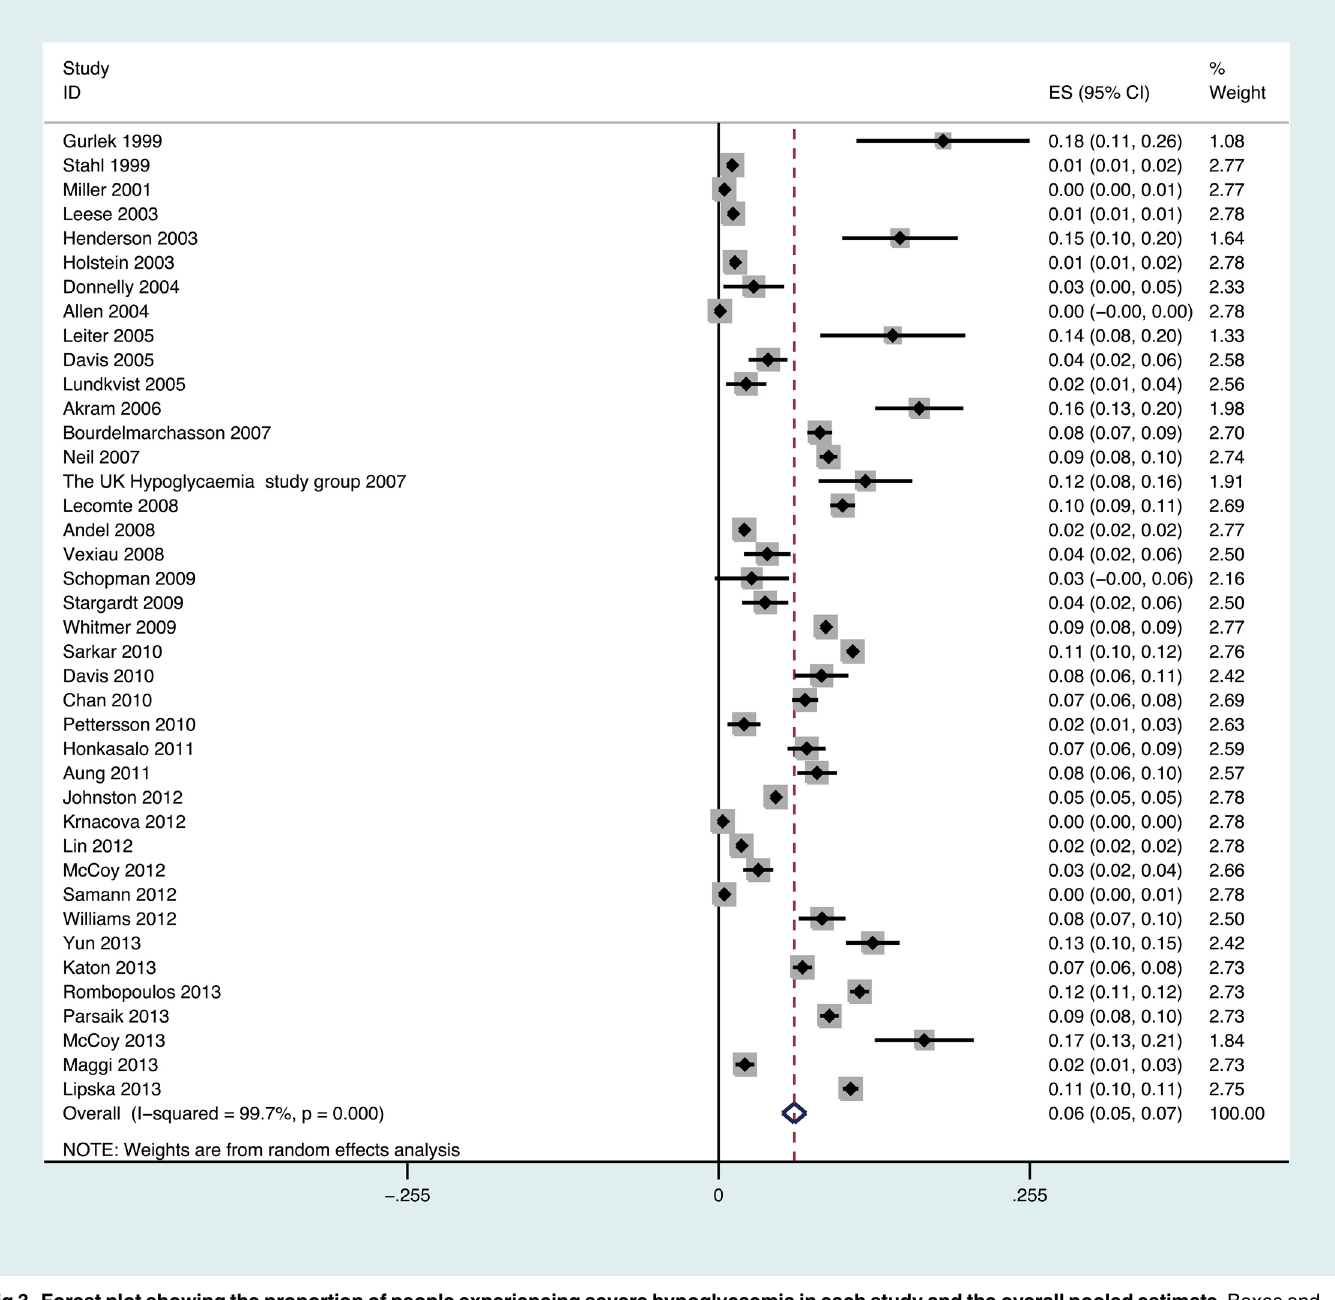
Fig 3. Forest plot showing the proportion of people experiencing severe hypoglycaemia in each study and the overall pooled estimate. Boxes and horizontal lines represent proportion if people experiencing severe hypoglycaemia and 95% CI for each study. Size of box is proportional to weight of that study result. Diamonds represent the 95% CI for pooled estimates of effect and are centred on pooled hypoglycaemia incidence.